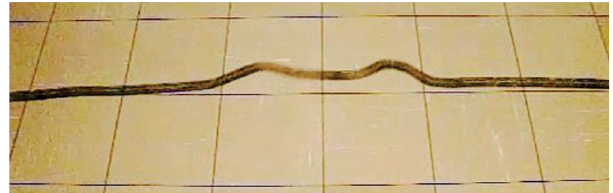
FIG. 5. The outcome of the testing experiment shown in Fig. 3 at the moment when the pulses meet. The displacement at the meeting location is significantly smaller than the amplitudes of the pulses but not zero. Students realize that the prediction included an assumption that the pulses have the same amplitude.